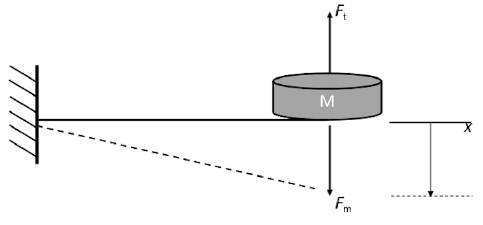
Figure 2. Forces acting on a “mass-spring” system. Table 1. Characteristics of the steel spring